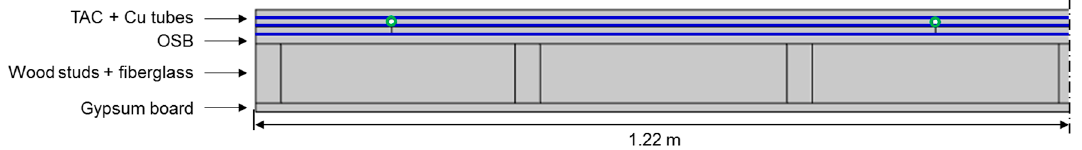
Figure 2. COMSOL rendering of the schematic cross-section of the “Base + TAC” wall. The TAC consisted of three alternating layers of 1.3 cm thick XPS sheets and 0.13 mm thick Al